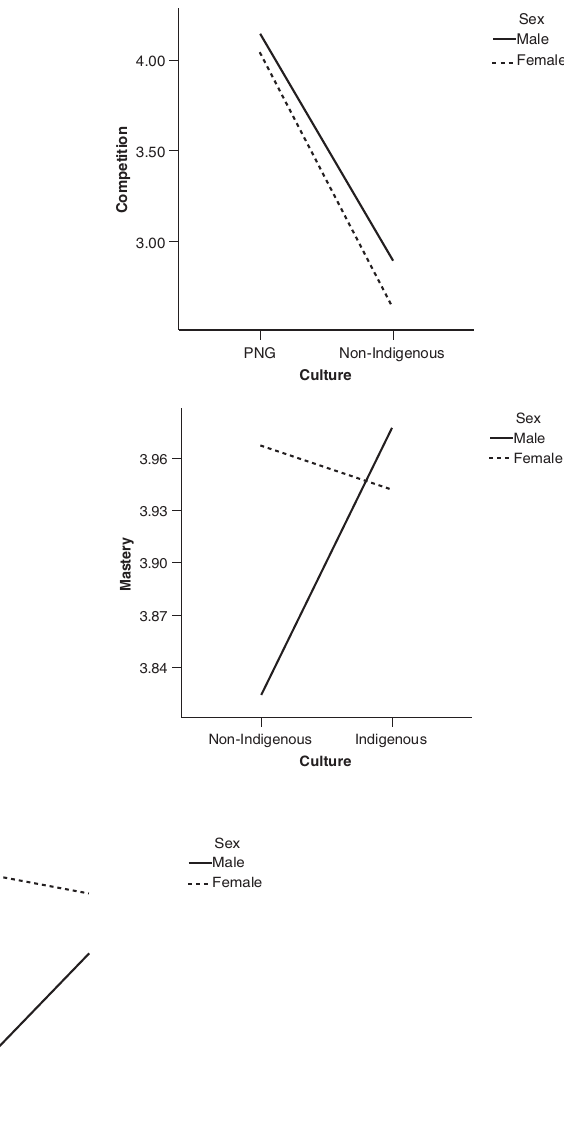
The gender × culture interaction for mastery goal orien- tation showed that in the non-Indigenous group, females were more strongly mastery orientated than males; con- versely, in the Indigenous group males had a stronger mas- tery orientation than females. The results also indicated that both male and female Indigenous students were com- parable on their endorsement of social concern goals. In contrast, there was a difference between males and females in the non-Indigenous group, with males scoring signifi- cantly lower than females, as indicated by the gender main effect